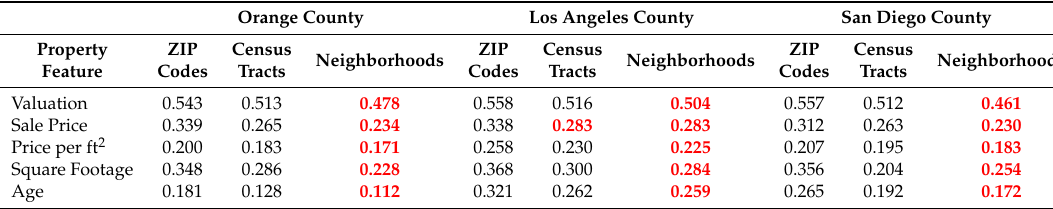
Table 2. Average unbiased estimate of coefficient of variation for each tabulation criteria across 3 counties (lower is